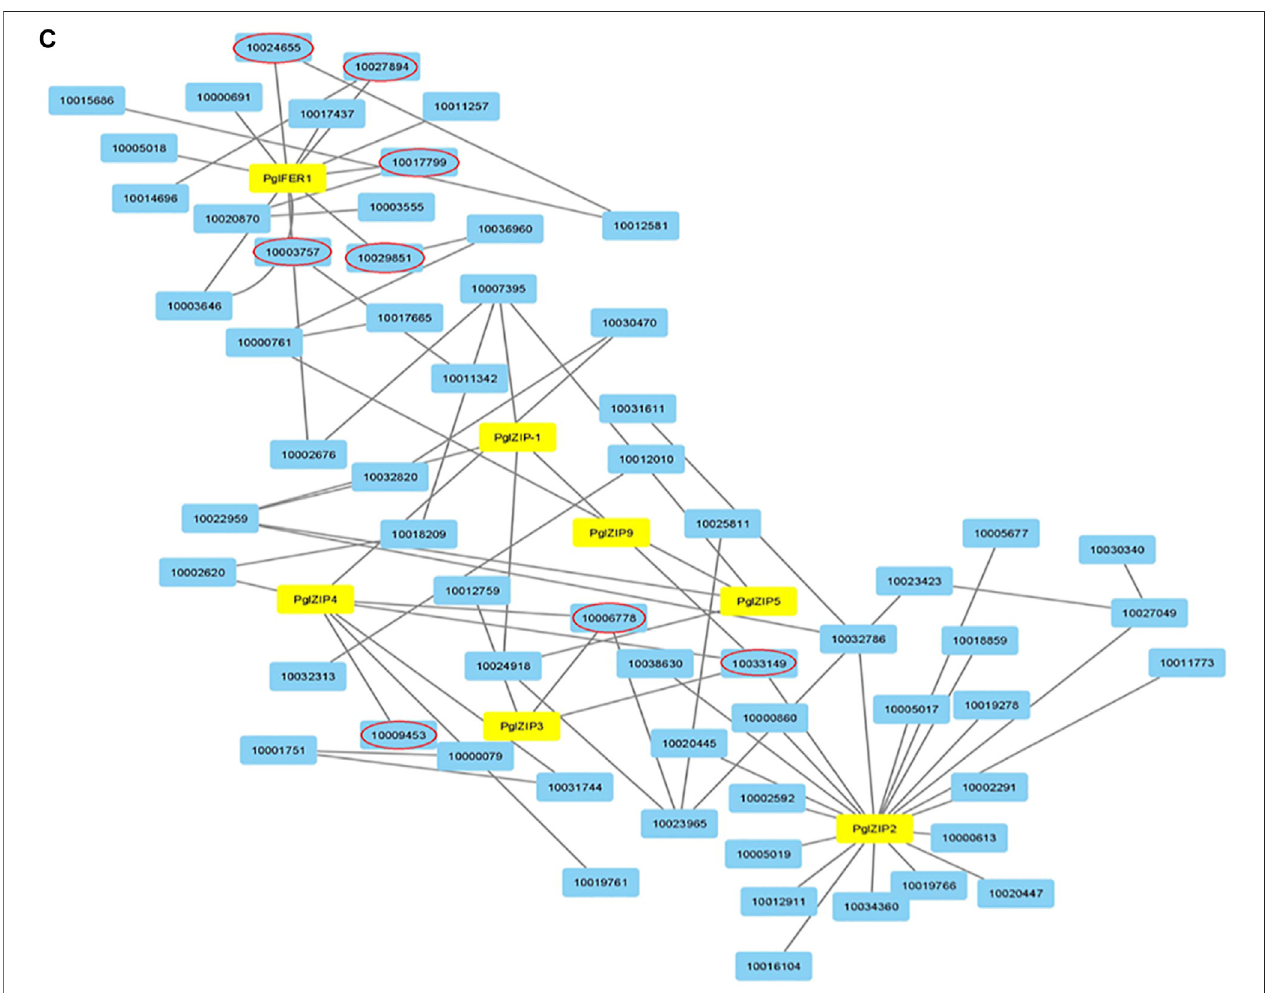
FIGURE 3 | Protein-protein interaction (PPI) network for 7 putative proteins. Yellow colored nodes have been short listed from 29 unique proteins (Mahendrakar et al., 2020) and other interacted nodes (red circled) involved in Fe and Zn metabolism and transport and other functions like ATP binding, phosphotransferase activity, carbohydrate metabolism and hexokinase activity (Data source: Mahendrakar et al., 2020).